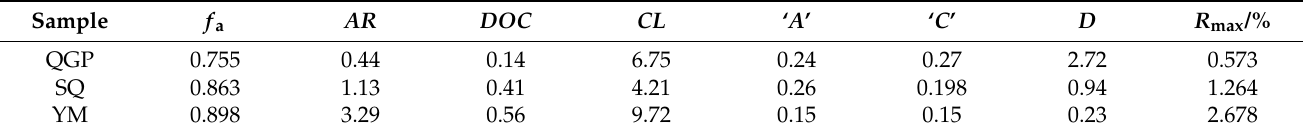
Table 3. Results of semi-quantitative structural